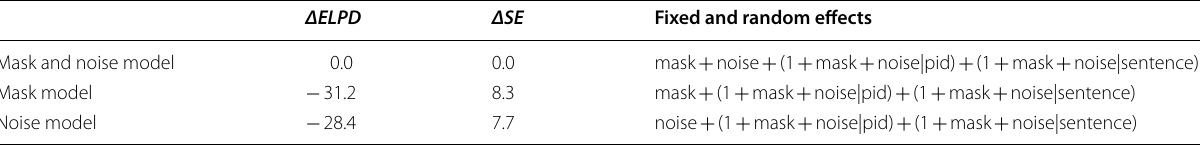
Table 2 Change in LOO information criterion relative to the best fitting model without an interaction term for the sentence intelligibility analysis with young adults